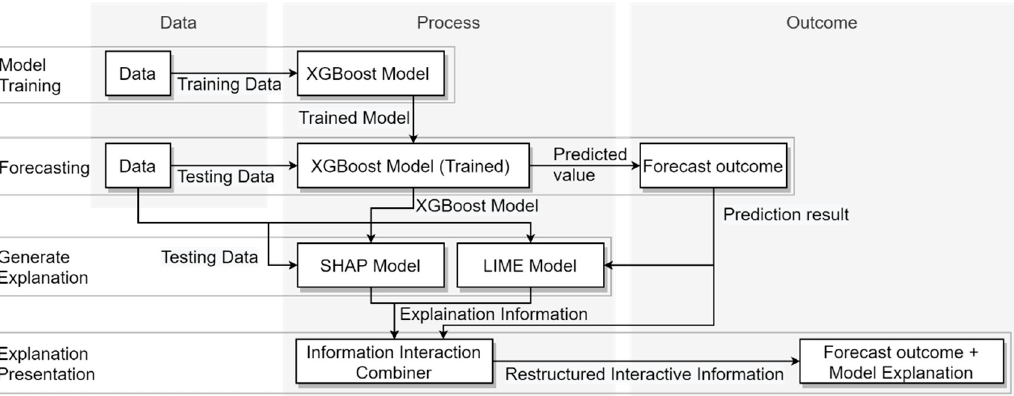
Figure 3. Process framework of the prediction model.